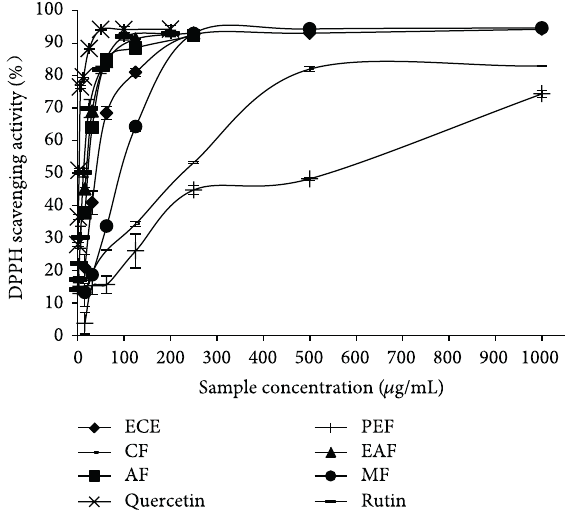
Figure 2: Scavenging effect on DPPH radical of extracts and fractions from Z. bungeanum leaves. Rutin and quercetin were used as the positive